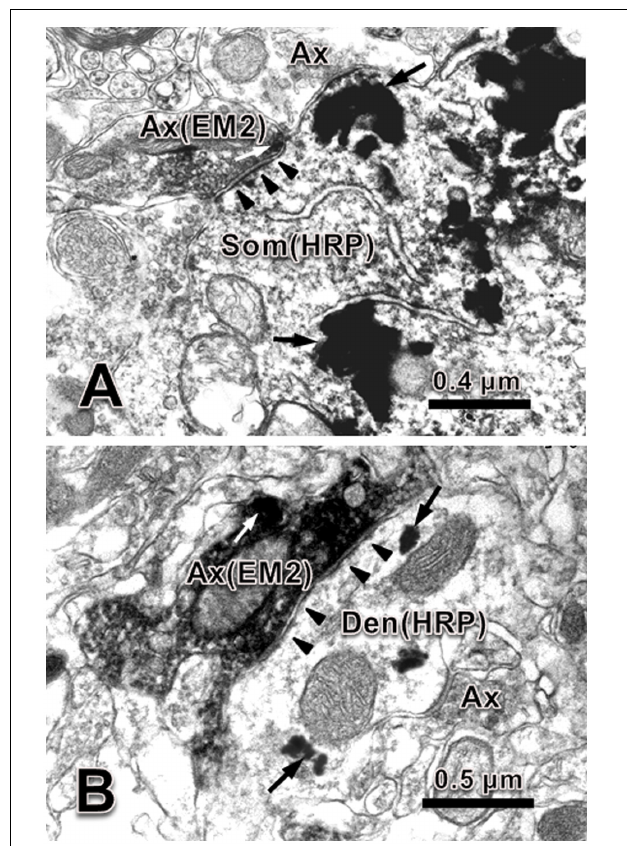
FIGURE 2 | Synaptic connection between EM-2-IR terminal and HRP labeled dendrite and soma of motoneuron in spinal ventral horn. (A) An EM-2-IR axon terminal (Ax) contained EM-2-immunopositive large dense coated vesicle (white arrow, labeled with DAB reaction products) made symmetric synapse with an HRP (black arrows, labeled with TMB-ST reaction products) labeled soma (Som). (B) An EM-2-IR axon terminal contained several EM-2-immunopositive large dense coated vesicle (white arrow, labeled with DAB reaction products) made symmetric synapse with an HRP (black arrows, labeled with TMB-ST reaction products) labeled dendrite (Den). Black arrowheads indicate the postsynaptic membranes. Scale bars = 0.4 µ m in (A) , 0.5 µ m in (B)